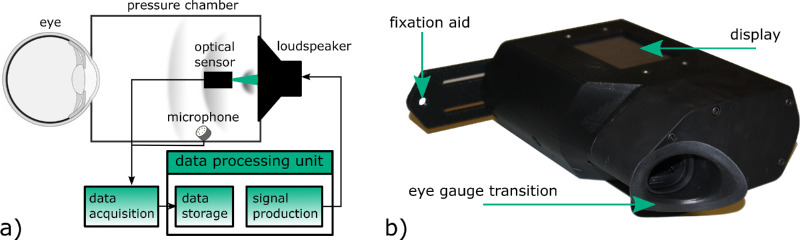
(a) Schematic working principle of acoustic self-tonometer. (b) Prototype of self-tonometer that was used for data acquisition on humans in the clinical trial series.